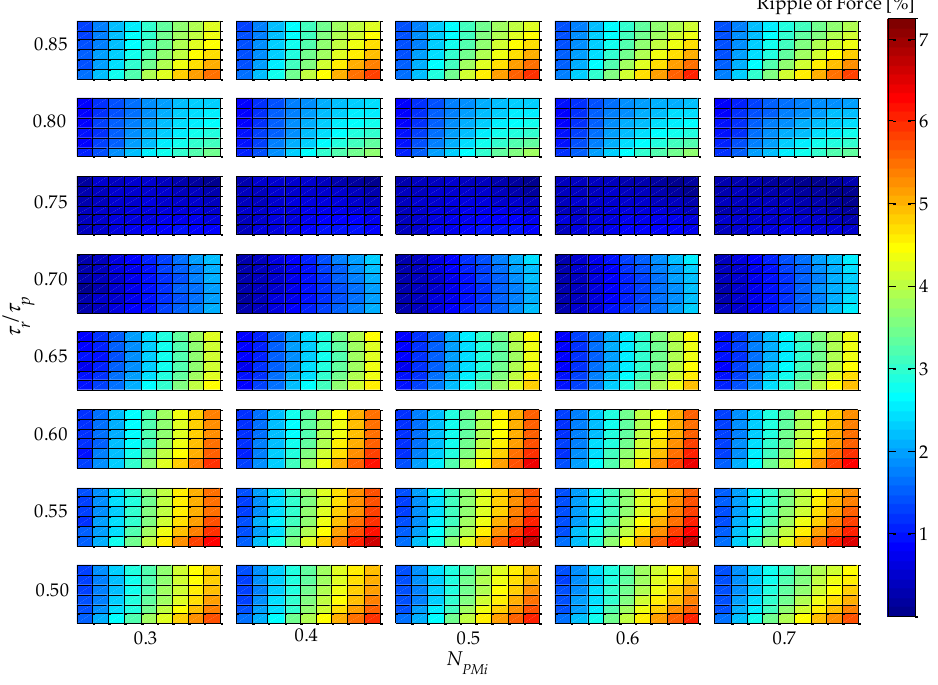
Figure 7. Results of absolute percentage static force ripple of the uncoupled design for four parametric variables: τ r / τ p , N PMi , N CPMs , and n form .